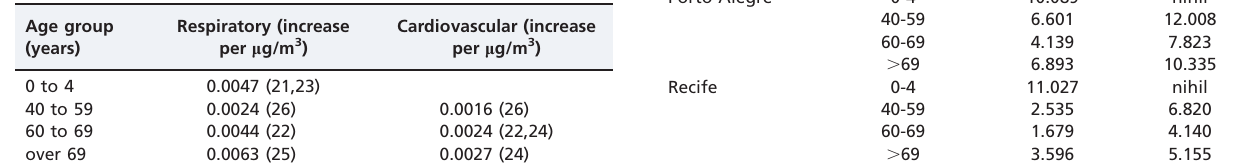
Table 1 - The age groups considered in this study and the corresponding risk coefficients relating PM2.5 concentrations to a given health effect.